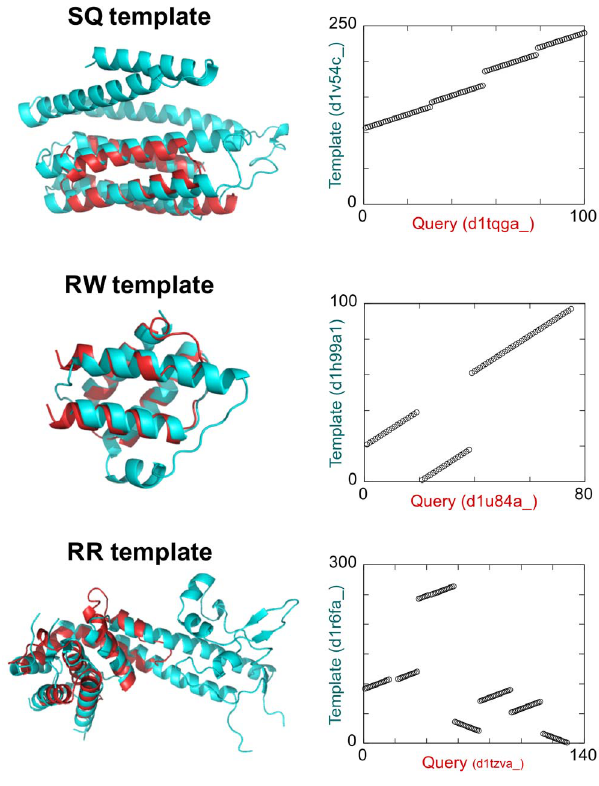
Figure 2. Typical examples of the SQ, RW, and RR templates. The cartoon structures on the left present the superposition structures of a query (red) and the closest structure (cyan) to the query. The figures on the right are alignment plots, on which aligned residue pairs are represented as circles. The horizontal axis of the plot represents the residue number of the query protein, and the vertical axis represents that of the template.